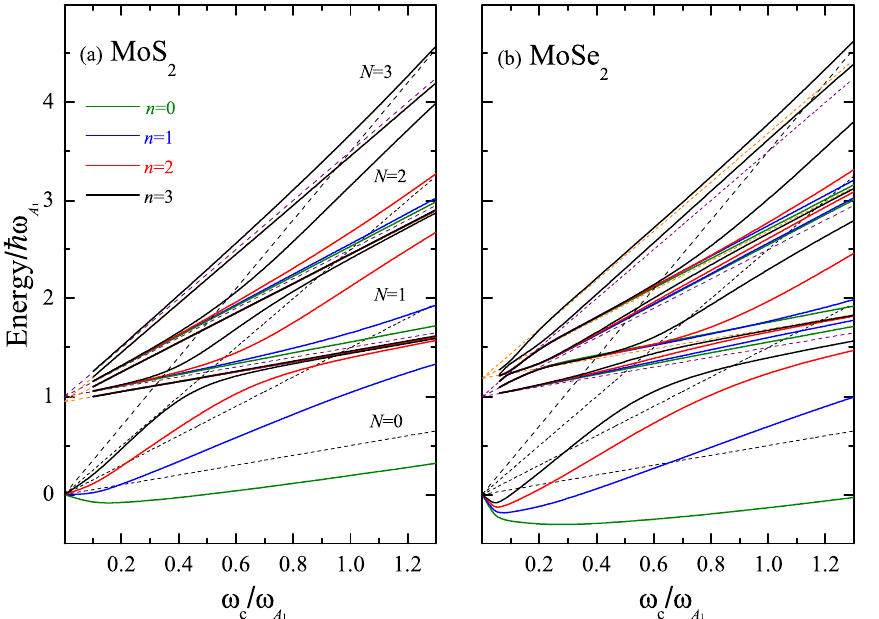
Figure 3. Magneto-polaron spectrum, ˆ ǫ n / (cid:31) ω A 1 , as a function of ω c /ω A 1 for the set of four states with the quantum numbers n = 0, 1, 2, and 3 for ( a ) ML MoS 2 and ( b ) ML MoSe 2 . The solid lines show the renormalized Landau levels calculated according to Eqs. (6) and (7). The black dashed lines represent the bare Landau level energies with N = 0, 1, 2, and 3, while the orange and violet dashed lines display the bare excited states (cid:31) ω (cid:31) ω LO + ( p + 1 / 2 ) (cid:31) ω + ( p + 1 / 2 ) (cid:31) ω c ( p =0, 1, and 2). For each label p , the first four dressed A 1 c and excitations ( n = 0, 1, 2, and 3) are included.